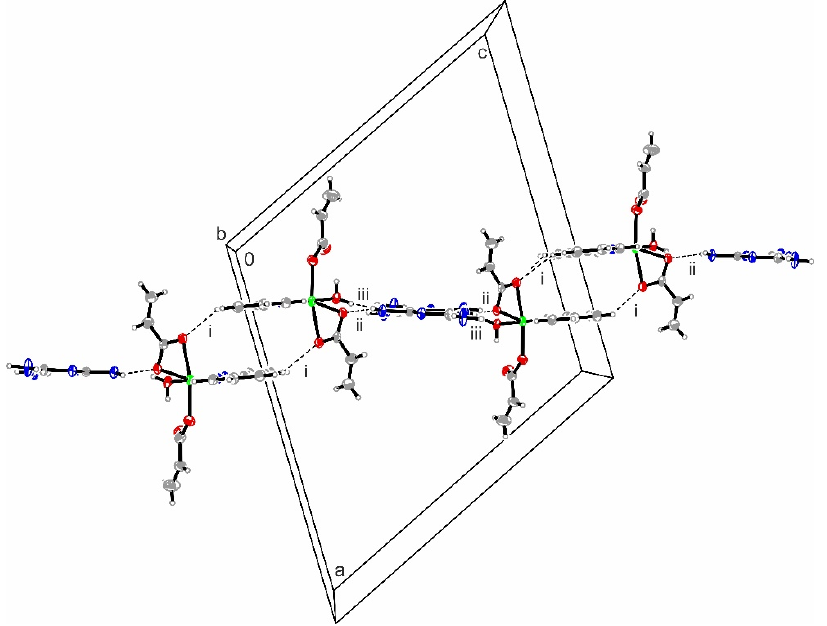
Figure 1. Excerpt of the packing diagram of co-crystal 1 representing the interactions between the nickel complex and the melamine molecules perpendicular to the ac -diagonal.